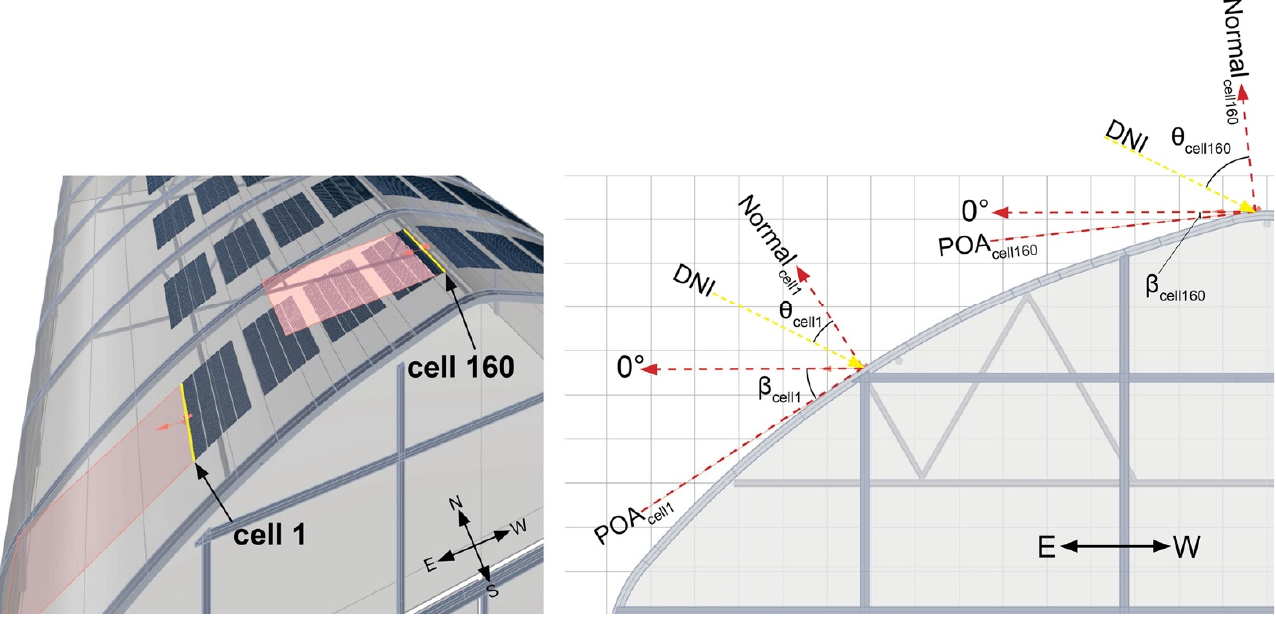
Figure 5. Calculation of the surface tilt angle ( β ) and angle of incidence ( θ ) from the direct normal irradiance (DNI) and the normal angle (Normal) to the plane of array (POA) of individual OPV cells on the greenhouse roof; the most horizontal cell surface is located nearest the roof apex and the least horizontal is located nearest the ground.